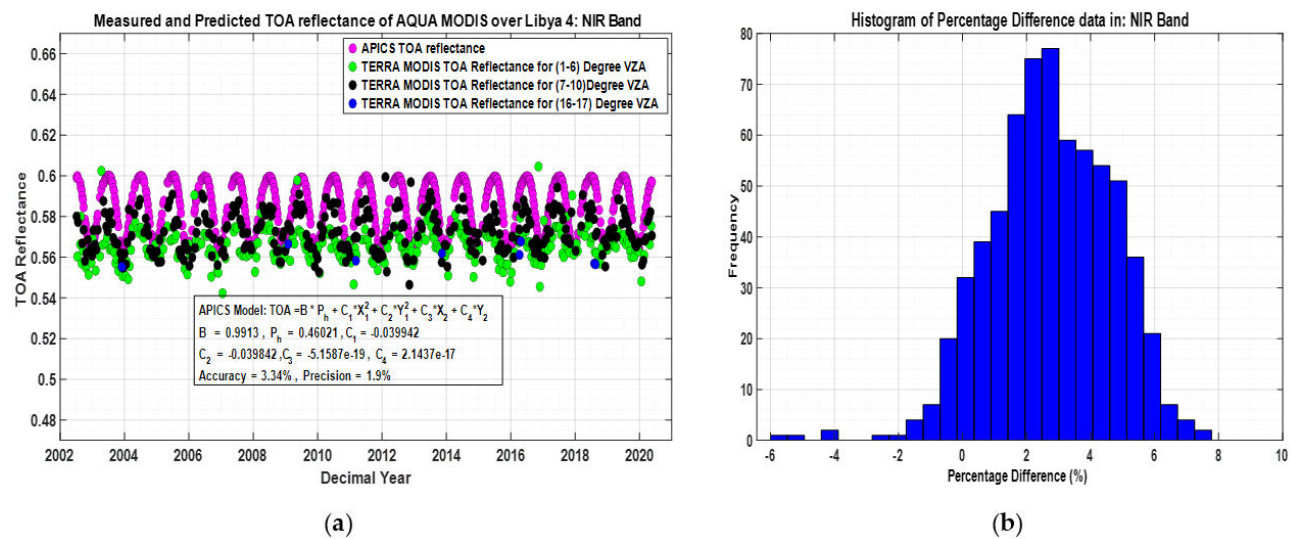
Figure 18. ( a ) Aqua MODIS observation over Libya 4 (green, black, blue circle) and model prediction (magenta circle) in NIR band; ( b ) percentage difference analysis plots of the model in NIR band of Aqua